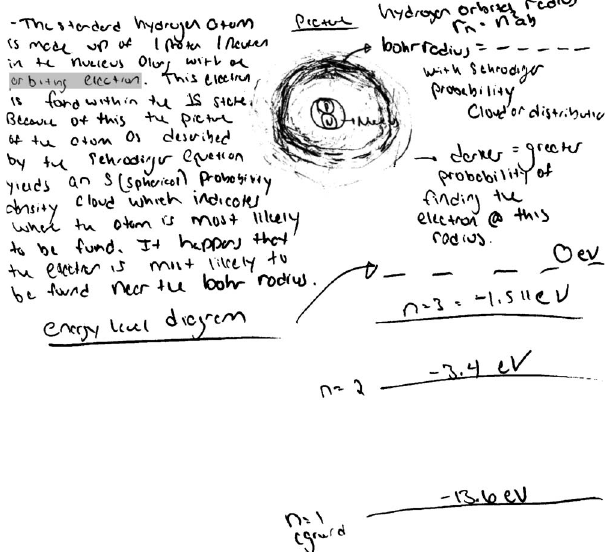
FIG. 6. Example of a student response coded as implicitly using the Bohr and Schrödinger models. This student drew and described a probability cloud or distribution, a characteristic of the Schrödinger model, but also described an “orbiting electron” (cid:1) high- lighted (cid:2) , a characteristic of the Bohr